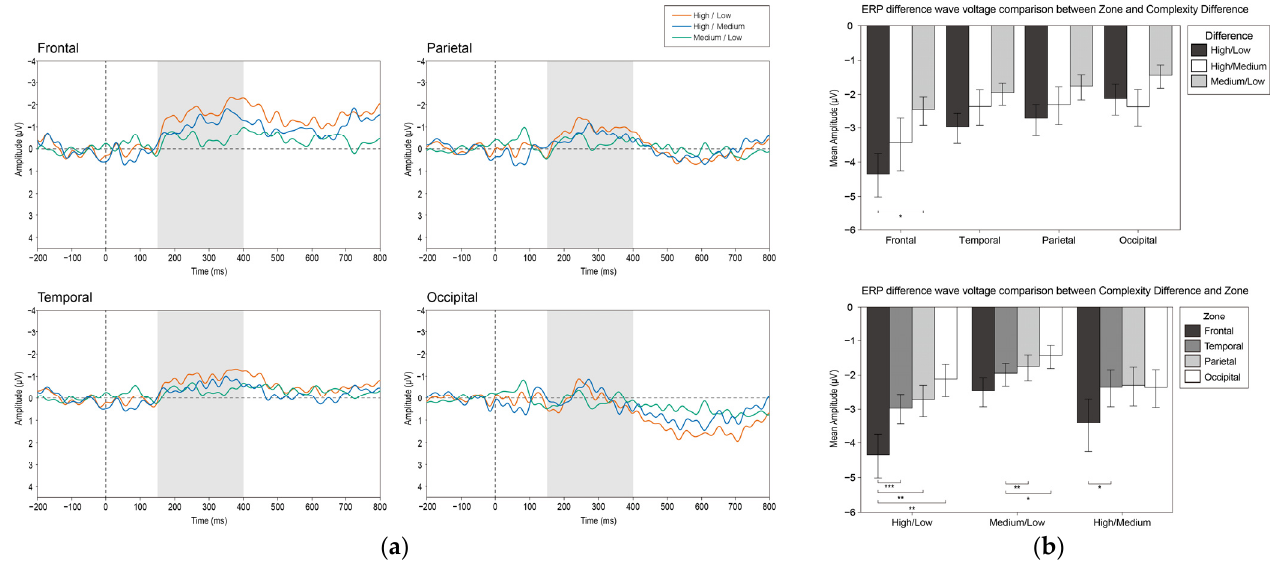
Figure 7. ( a ) The grand average waveform of the vMMN. The wave in blue represents the high/medium condition, the wave in green represents the medium/low condition, and the wave in red represents the high/low condition. The gray bars indicate the time window of the vMMN. ( b ) The bar plots of the interaction effect of the vMMN. Values plotted are means ± standard errors. Stars indicate significance levels: * = p < 0.05, ** = p < 0.01, *** = p < 0.001.